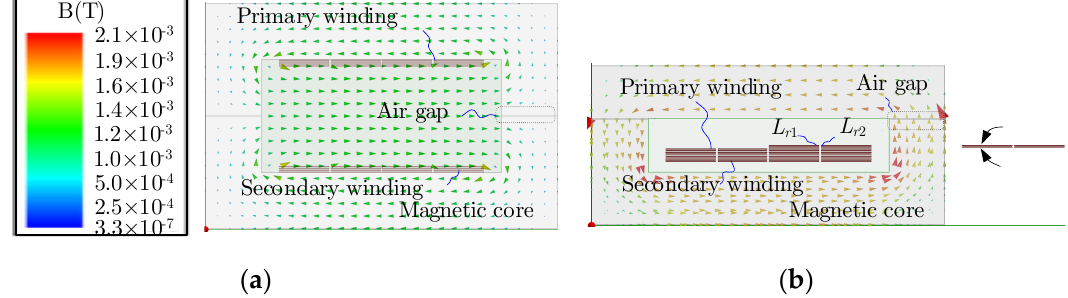
Figure 6. 2D structure of the magnetics and their simulation results with: ( a ) Conventional structure; ( b ) Proposed integrated magnetic structure.